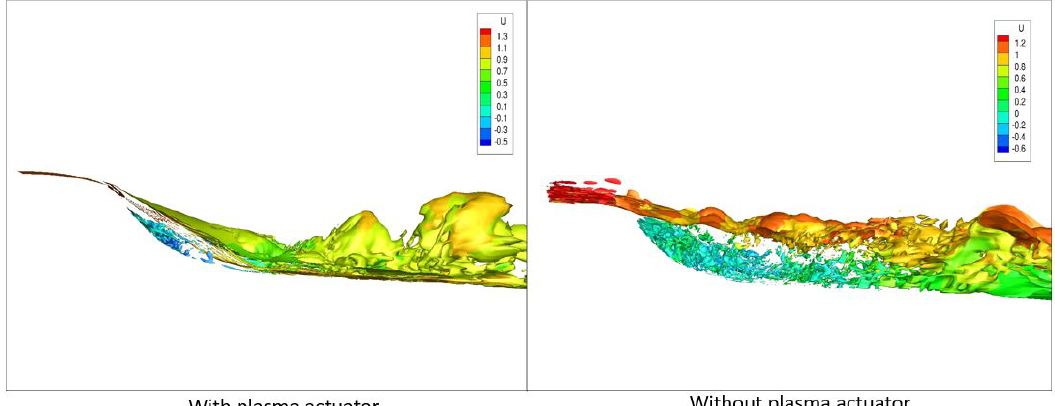
Figure 18. Instantaneous iso-surface of Q-criterion with the active plasma actuator.